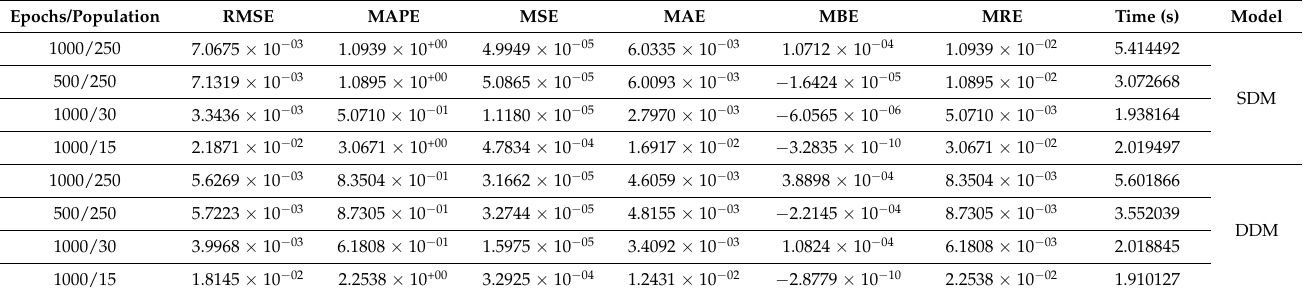
Table 24. Influence of the epochs and population on the statistical tests—RTC silicon photovoltaic cell.